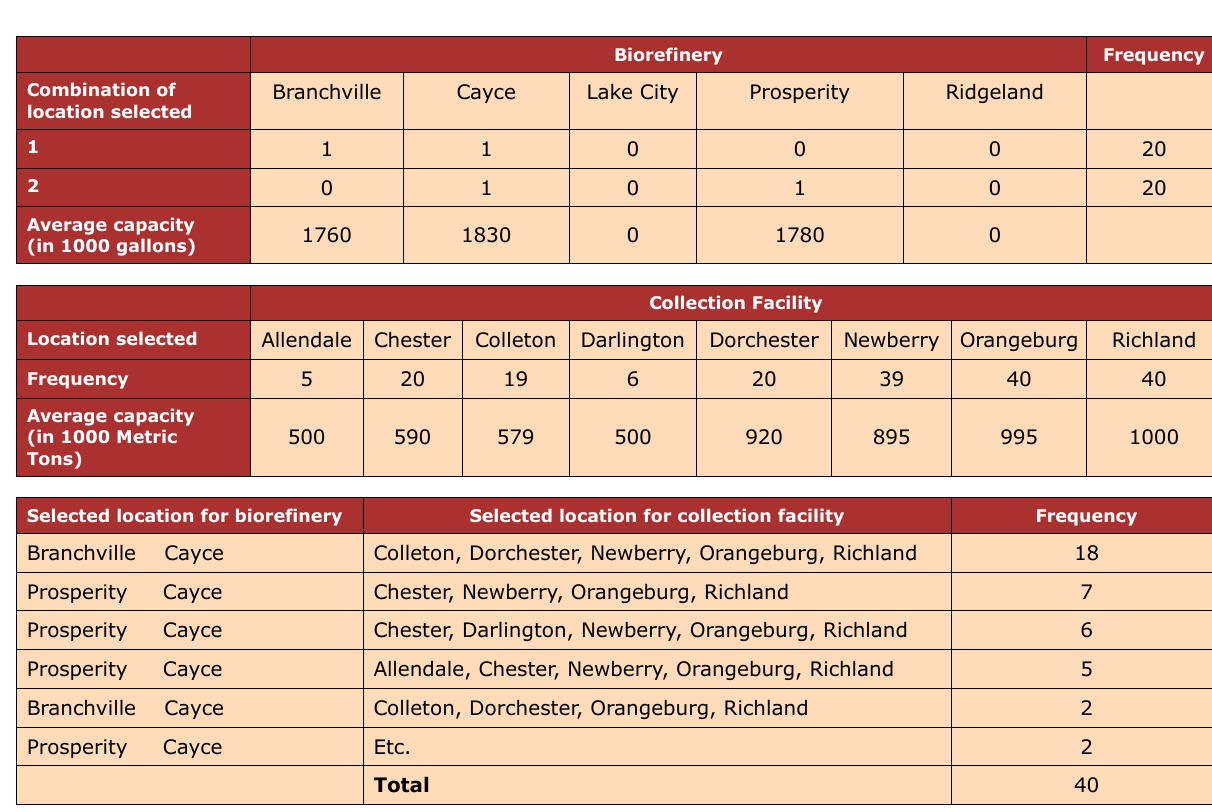
Table 2b. Simulation Results of Locations of Biorefinery and Collection Facility for Case